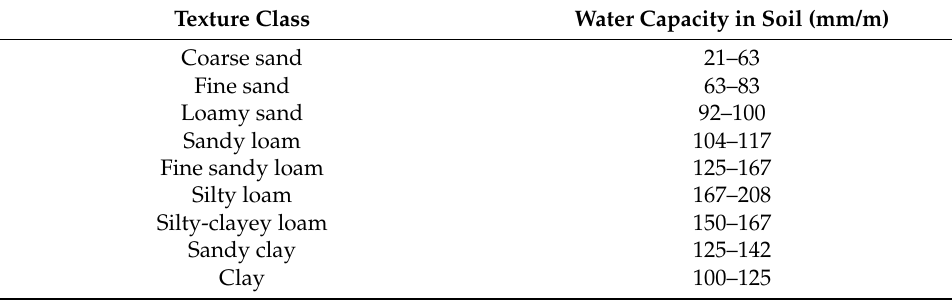
Table 6. Range of maximal water capacity in soil after texture soil